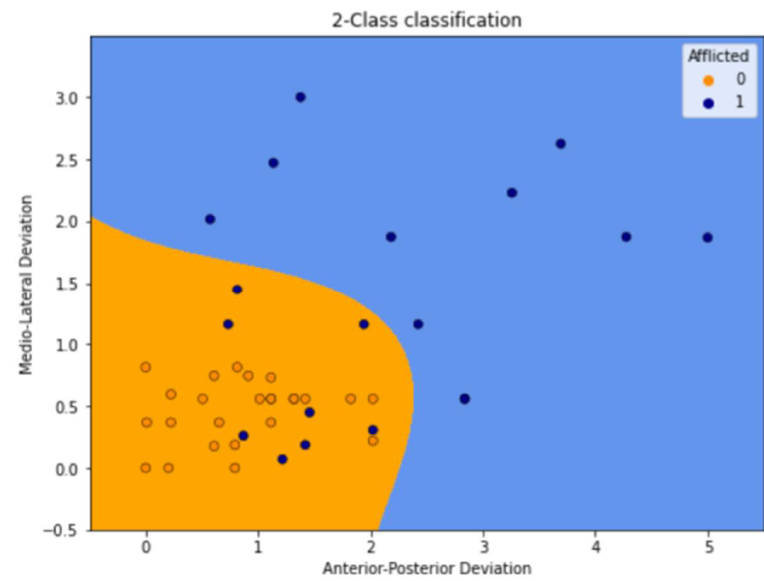
Figure 8. Prediction as seen on a graph.